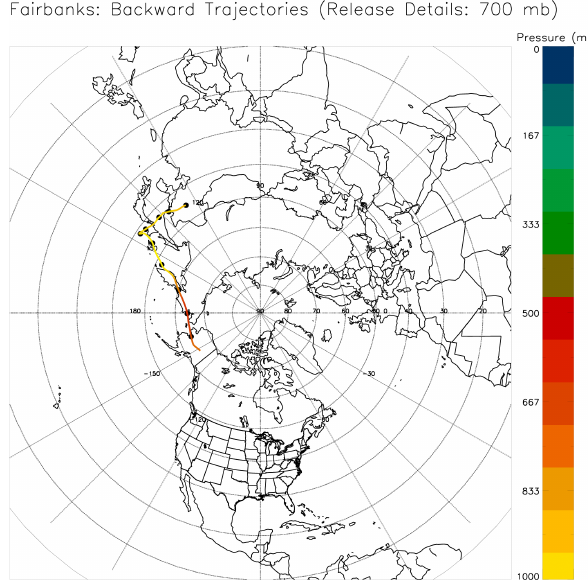
Fig. 15. FLEXPART back trajectory ending 13 April 2008 at 700hPa over Fairbanks, Alaska. Each black dot represents one day. Large red circles indicate regions of southeast Siberian fire activity.